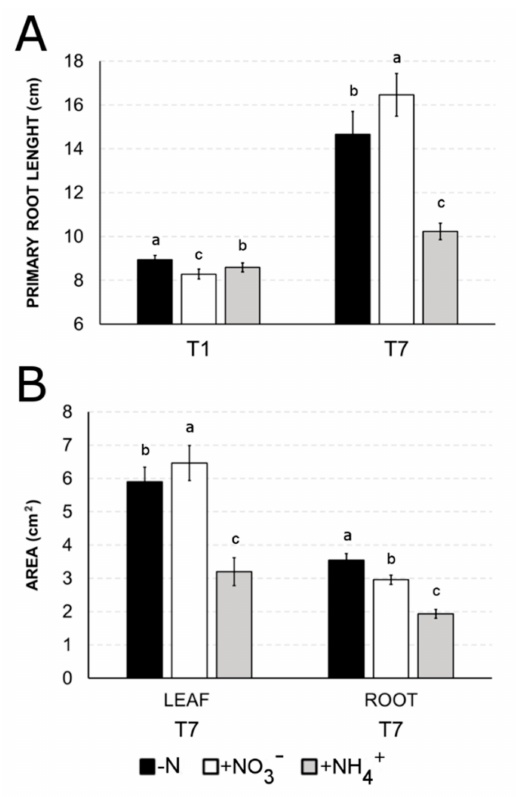
Figure 6. E ff ect of di ff erent N-source (NO 3 − or NH 4 + ) or N-deficiency (-N) primary root length (cm, panel A ) and surface area (cm 2 , panel B ). T1 shows the e ff ect after 24 h of treatment, T7 after 7 days. Surface area was obtained for both roots and leaves only at T7. Similar letters at the top of the bars are not significantly di ff erent ( p < 0.05) by an ANOVA test. Each value is designed as the mean of three biological replicates ±